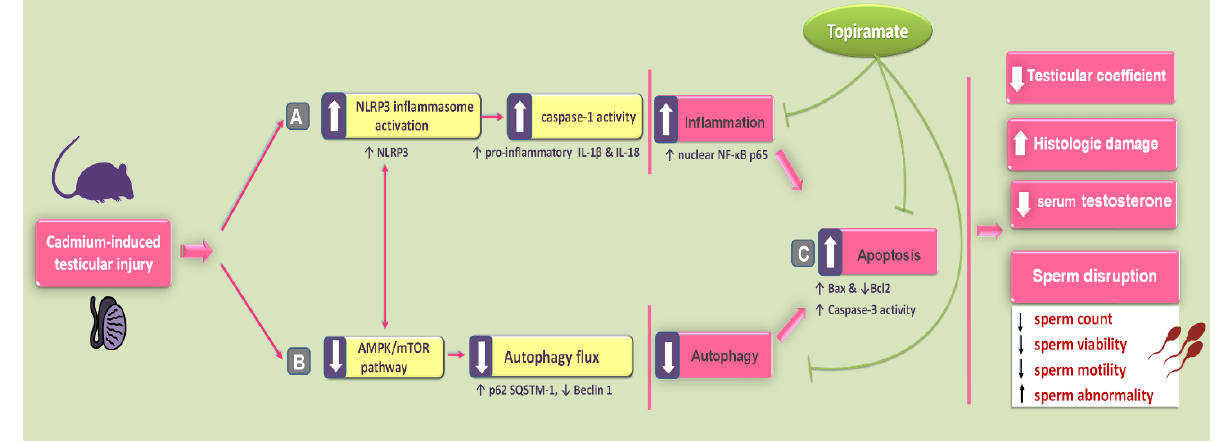
Figure 9. A summary of the molecular mechanisms that support the ameliorative impact of topir- amate against cadmium-triggered testicular damage in rats. The observed improvement of testicu- lar impairment and disrupted spermatogenesis were mediated by (A) Suppression of the NLRP3/caspase-1/IL- 1β axis and curbing of NF - κB activation. (B) Inhibition of the pro -apoptotic events by lowering Bax protein expression and caspase-3 activity alongside upregulating the anti- apoptotic Bcl-2. (C) Stimulation of AMPK/mTOR-driven autophagy in the testicular tissues of rats. Notably, the observed autophagy stimulation is likely engaged in the suppression of NLRP3 inflam- masome and associated pro-inflammatory events [7,15] and attenuation of the pro-apoptotic re- sponses [13,15,21] in the testicular tissues of animals. Solid arrows demonstrate activation while blunt arrows depict inhibition.